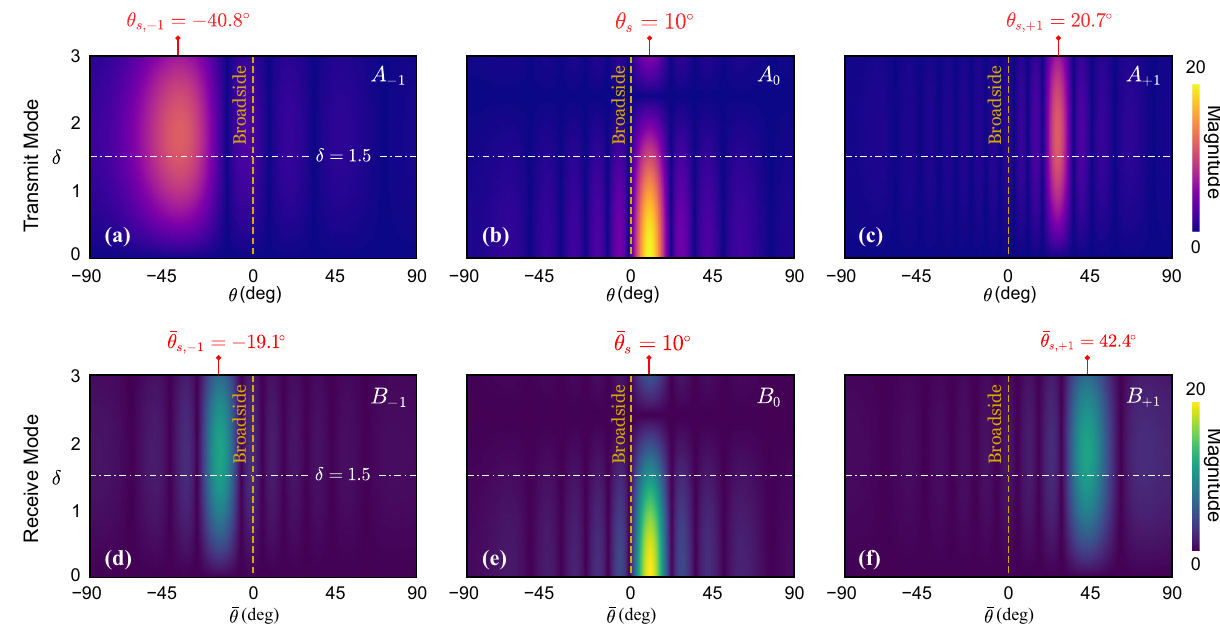
TX mode as a function of A A 0 and 1 in 1 , + − 10 40.8 1 ◦ , and ◦ , θ s = = − RX mode as a function − B B B 0 and 1 in 1 , + − 10 19.1 1 ◦ , and ◦ , ¯ θ s = = − − 1.0125 π rad/m, 500 Hz, κ s = = 1.5 =